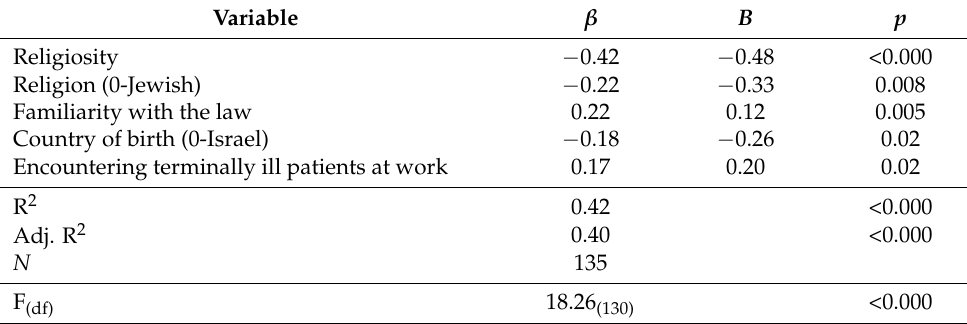
Table 5. Linear Regression Model for Attitudes toward